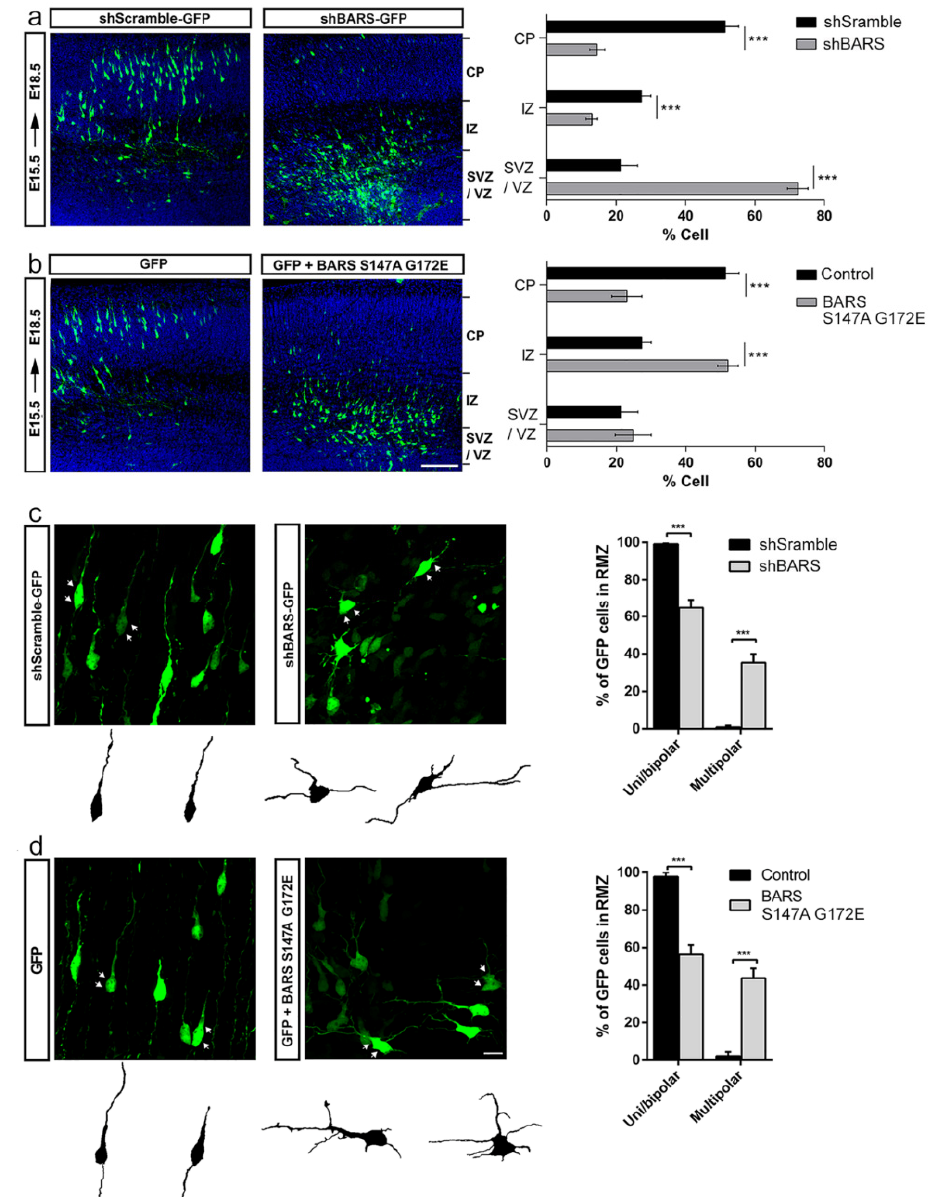
Figure 3. BARS regulates migration and multipolar-to-bipolar transition in cortical neurons in situ. ( a ) Left and middle panels: representative images of coronal cortical slices of mouse brain (embryonic day E18.5), expressing sc-shRNA-BARS-GFP (shScramble) or shRNA-BARS-GFP (shBARS) after IUE; right panel: quantification (%) of GFP-positive electroporated neurons by layers. VZ: ventricular zone, SVZ: subventricular zone, IZ: intermediate zone, CP: cortical plate. ( b ) Idem to previous panels, but after IUE of GFP or GFP + BARS S147A G172E; right panel: quantification (%) of GFP-positive electroporated neurons by layers. VZ: ventricular zone, SVZ: subventricular zone, IZ: intermediate zone, CP: cortical plate. Scale bar 100 µ m. ( c ) Left and middle panels: High magnification confocal images of cortical neurons expressing either sc-shRNA-BARS-GFP (shScramble) or shRNA-BARS-GFP (shBARS) at radial migration zone, RMZ; right panel: quantification (%) of uni/bipolar and multipolar morphologies in shScramble- and shBARS-expressing neurons. ( d ) Left and middle panels: high magnification confocal images of cortical neurons expressing either GFP or GFP + BARS S147A G172E. Scale bar: 10 µ m; right panel: quantification (%) of uni/bipolar and multipolar in GFP- and BARS S147A G172E-expressing neurons. For all experiments 10 slices were analyzed from 3 independent IUE for each experimental condition. Graphs represent mean ± S.E.M.; *** p < 0.001, Student’s t